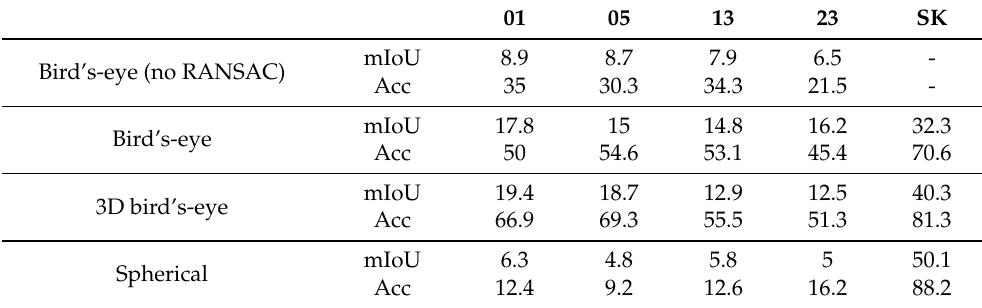
Table 7. Evaluation of models on new sensor and sensor setup. This table points out the dependency on the used setup. Within column SK, the validation results for the SemanticKITTI dataset are